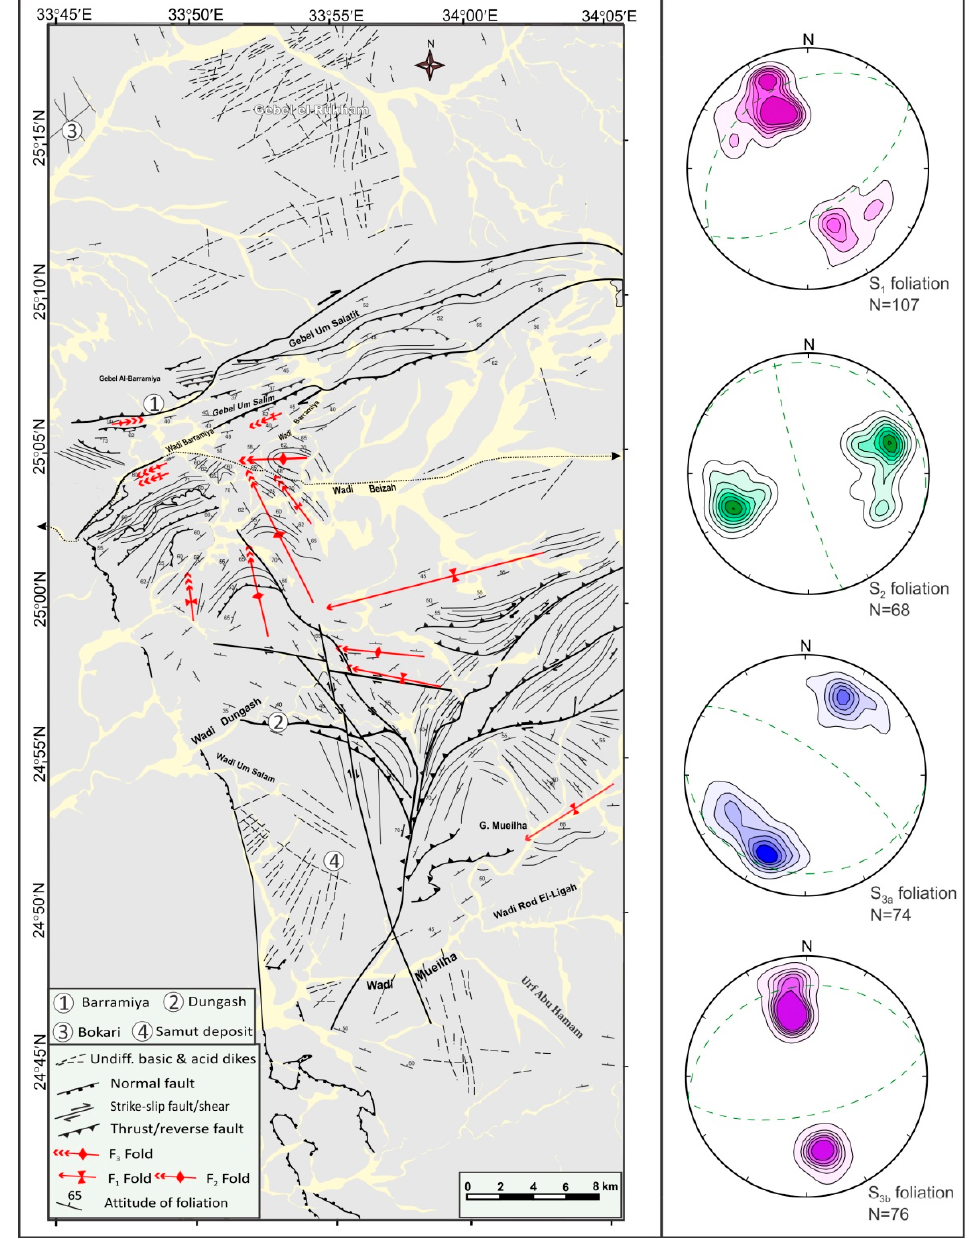
Figure 10. Simplified structural map of the Barramiya–Mueilha sector compiled from field measurements and satellite data interpretations. Several occurrences of gold–quartz veins are located in the area, but only significant gold occurrences/deposits are shown in the key. Insets are lower hemisphere stereographic projection for poles of the different generations of foliations.